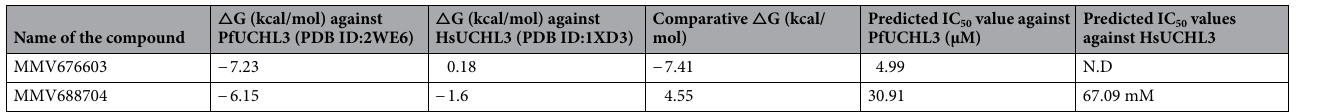
Table 1. Table presents the comparative binding energies and predicted IC 50 values of the identified hits by Autodock software. N.D—not determined because the binding energy of MMV676603 was in positive range i.e., 0.18, hence, the software was not able to predict its IC 50